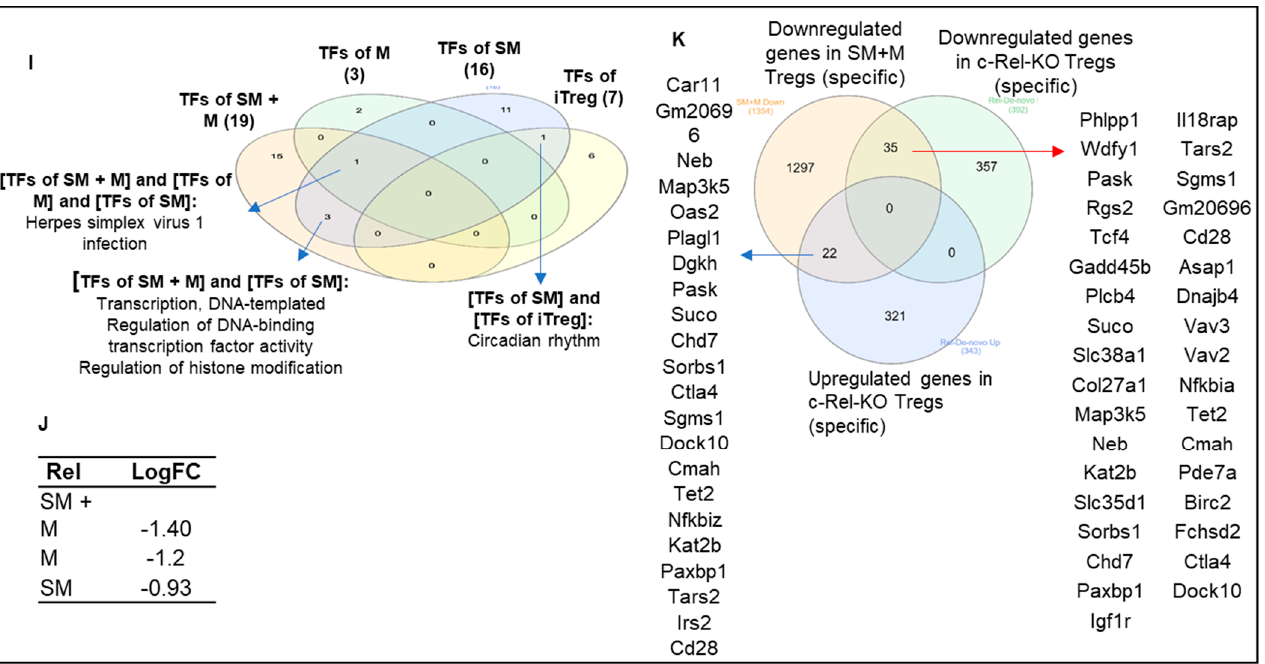
Figure 7. Cigarette smoke plus morphine, morphine, and smoke modulate the expression of tran- scription factors (TFs). ( A , B ) The ingenuity pathway analysis (IPA) showed that SM + M, M, and SM specifically upregulated 70, 16, and 24 and downregulated 75, 39, and 12 IPA-annotated TFs in Tregs, respectively. ( C – E ) The metascape pathway analysis of the specifically upregulated genes in SM + M, M, and SM, respectively. ( F ) SM + M, M, and SM modulated the expressions of 22, 17, and 14 out of 149 inducible Treg (iTreg)-specific TFs and 14, 8, and 5 out of 78 iTregs-Th17-shared TFs in mouse splenic Tregs, respectively. ( G ) The heat map was generated by using the value of log2FC of the TFs ( p -value < 0.05) in each comparison. The results showed that: (1) SM + M significantly upregulates the expression of four inducible Treg (iTregs)TFs including HDAC5, YAF2, MXD4, and PBXIP1, which were not upregulated in SM treated Tregs and M treated Tregs (red arrow). In addi- tion, SM + M upregulated three iTreg and Th17 shared TFs (red arrows) including PYCARD, PTTG1, PDZ, and PDLIM1; (2) SM upregulated TF ATF5 (green arrow) is SM specific; and (3) seven M downregulated TFs including CSRNP1, CEBPB, CREM, MXD1, FOXP3, IKZF4, TSC22D3 are M spe- cific. ( H ) The metascape pathway analysis for SM + M 15 upregulated iTreg-specific TFs. ( I ) The Venn diagram analysis indicated that SM + M Tregs overlaps one TF pathway with that of SM Tregs TFs and M Tregs TFs; SM + M Tregs TFs overlap three TF pathways with that of SM Tregs TFs, and SM Tregs TFs overlaps one TF pathway with that of iTregs TFs. ( J ) SM + M, M, and SM downregu- lated the expression of Rel (c-Rel) in Tregs ( p < 0.05). ( K ) 35 genes out of 1354 SM + M downregulated genes were overlapped with Rel-deficient Tregs downregulated gene.